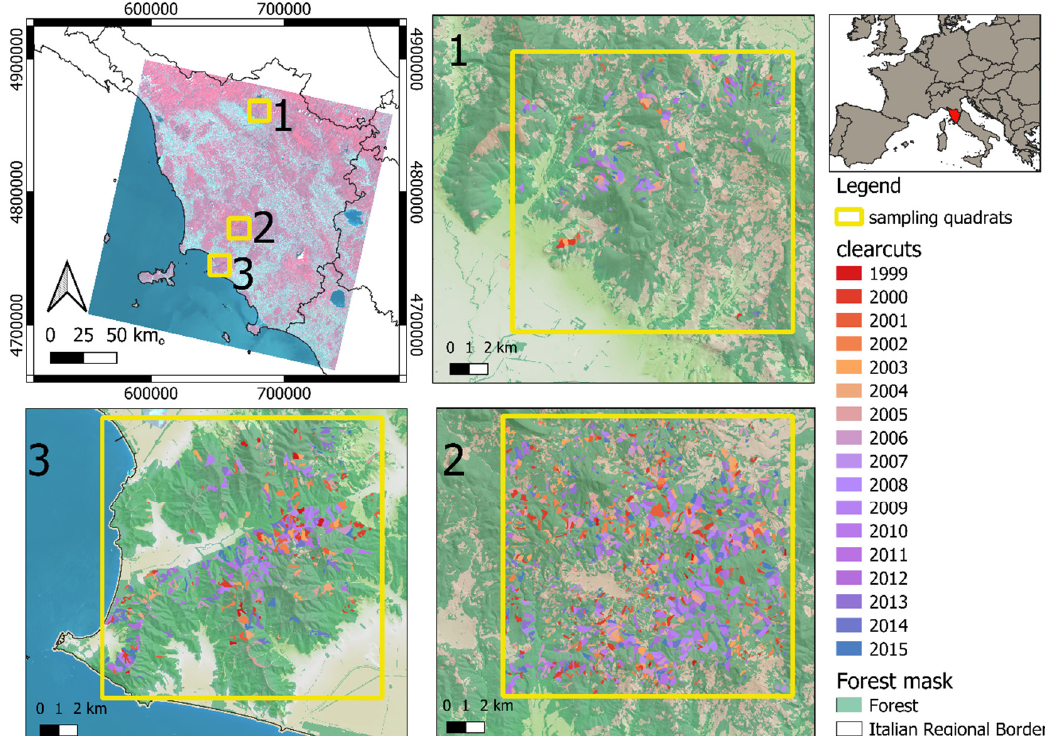
Figure 1. The upper left panel shows the location of the study area within Landsat scene 192 030 and the locations of the three quadrats. Panels 1, 2, 3 show the locations of clearcuts in the three quadrats of the clearcut reference dataset [32].